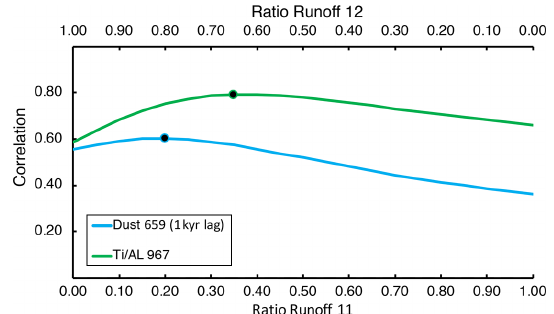
Figure 7. Correlation of the combined output of runoff from grid boxes 12 (top x axis) and 11 (lower x axis). For example, 0.5 and 0.5 indicate a runoff record consisting of 50% runoff 11 and 50% runoff 12. For each created record the correlation is computed over the full time period of 3.2 to 2.3Ma. Green: with Ti / Al of Site 967; light blue: with dust from Site 659 (lag of 1kyr). The dots indi- cate the maximum correlation for the Ti / Al record of 0.35R11 + 0.65R12 (0.792) and for Site 659 of 0.2R11 + 0.8R12